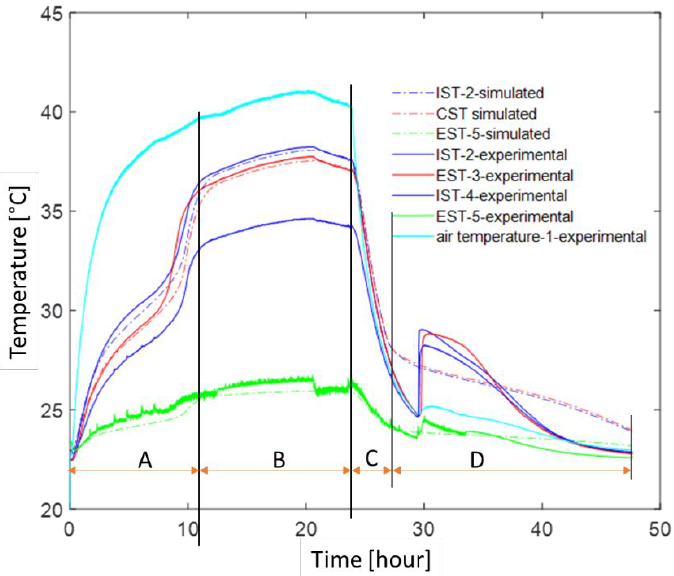
Figure 12. Comparison of temperature profiles of experiment and simulation at different wall locations for case e. IST: Internal surface temperature; CST: contact surface temperature; EST: external surface temperature. A: heating process; B: steady-state process; C: cooling process; D: sub-cooling to end.